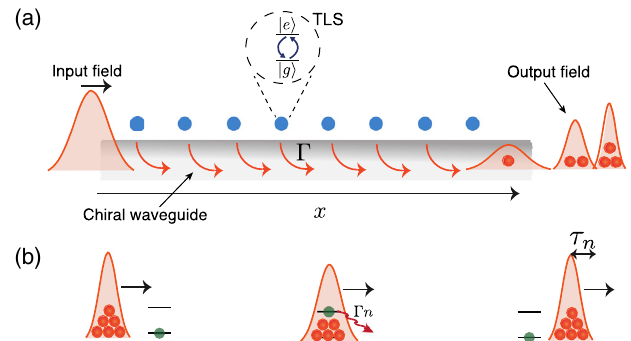
FIG. 1. (a) N two-level atoms (blue circles) are chirally coupled to a waveguide with decay rate Γ and driven by an input Gaussian pulse, which can be a coherent or Fock state. The light pulse propagates with a correlation-number-dependent group velocity leading to an output state where one-, two-, and three-photon bound states are spatially separated. (b) Sche- matic of the bound-states propagation. When an n -photon bound state is scattered by an atom, it reemits the absorbed photon with a stimulated emission rate Γ n , coinciding with the inverse of its width. Since only a single photon out of n is delayed by an amount 4 = ð Γ n Þ , the pulse preserves its shape but 4 = ð Γ n 2 Þ is delayed by τ n ¼ produce a pulse with three-photon correlations followed photons. The underlying physics that causes this time delay is examined by considering the many-body photonic